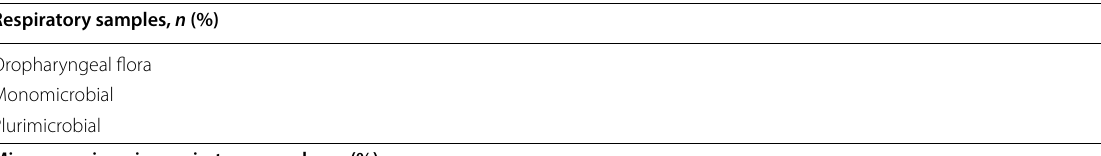
Table 2 Micro-organism data in respiratory samples